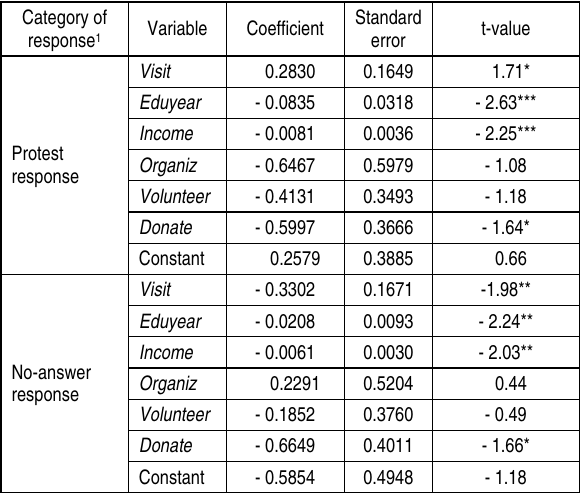
Table 2. Results of multinomial logit estimation for identification of response